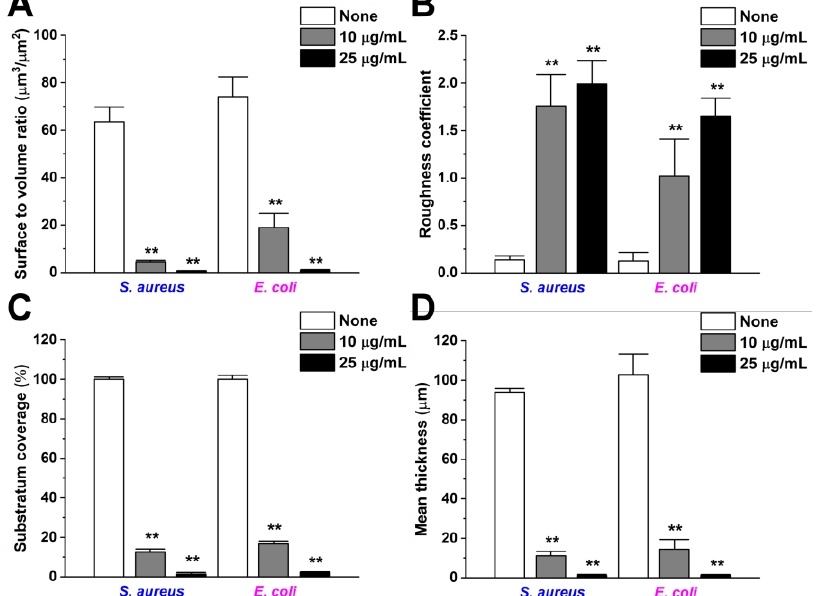
Figure 8. Effects of Ch/Poly (C-fu) (40/60) on S. aureus , and E. coli biofilm biomasses, surface to volume ratio ( A ), roughness coefficient ( B ), substratum coverages spatial characteristics ( C ) and mean thicknesses ( D ) were quantified by COMSTAT analysis. **, p < 0.01 vs. non-treated controls.